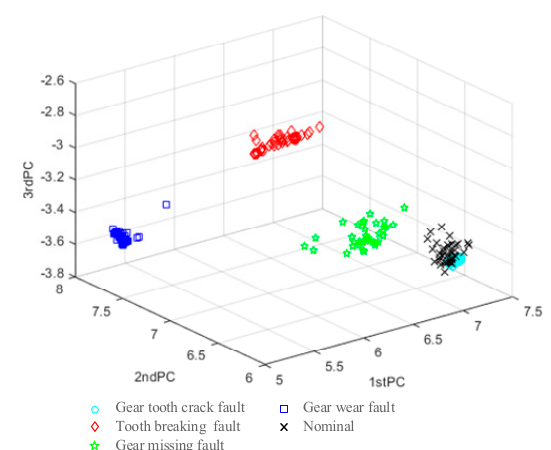
Figure 15. Clustering result of variational mode decomposition (VMD)-time-frequency information entropy under condition 1.